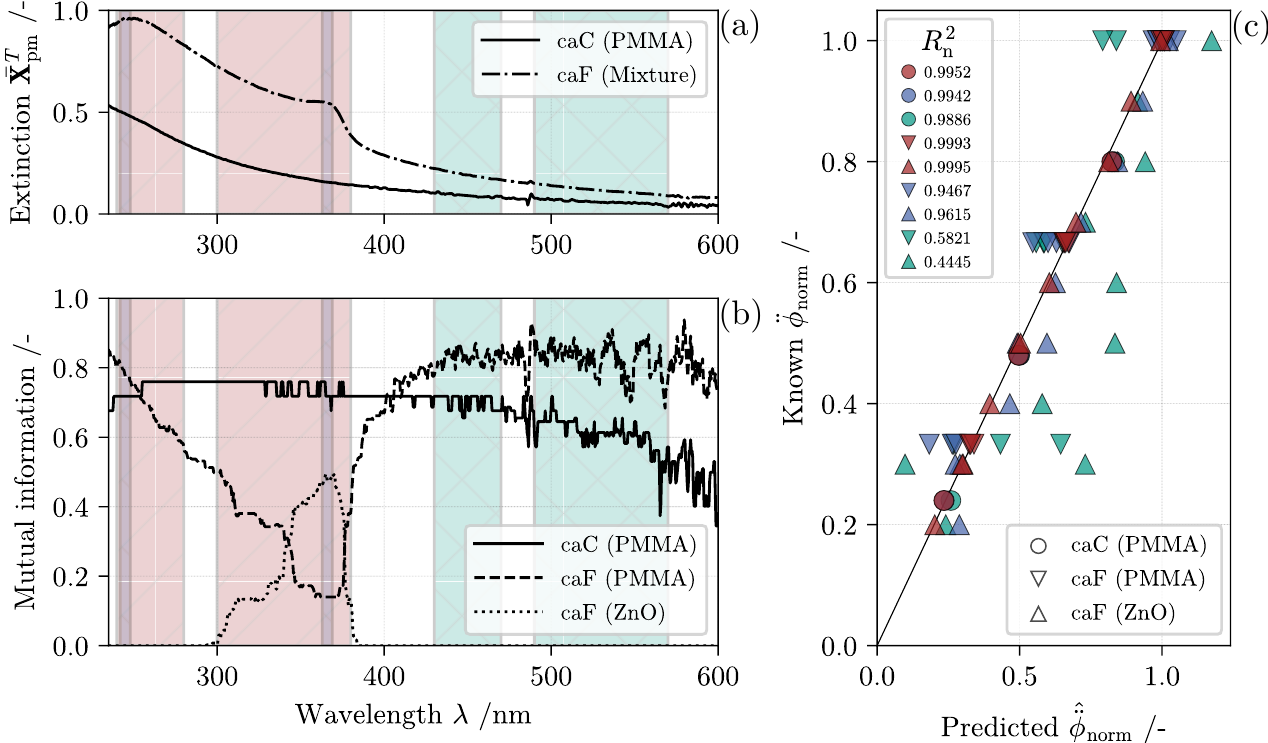
Figure 7. Outcome of applied data pre-processing and model diagnostic. On the left in the background, three selected data segmentation zones are displayed: feature range FR1 (blue, hatched sideways from top to bottom), FR2 (red, hatched sideways from bottom to top) and FR3 (green, cross hatched). ( a ) Mean extinction of calibration data set caC and caF drawn over the wavelength range of interest. ( b ) Mutual information for components PMMA and ZnO at every wavelength. ( c ) Visual inspection of model suitability plotting predicted ˆ¨ φ n,m against known ¨ φ n,m concentrations. Data points are normalized to the highest volume fraction in each column of matrix ¨ Y . For every component, the coefficient of determination R 2 n is